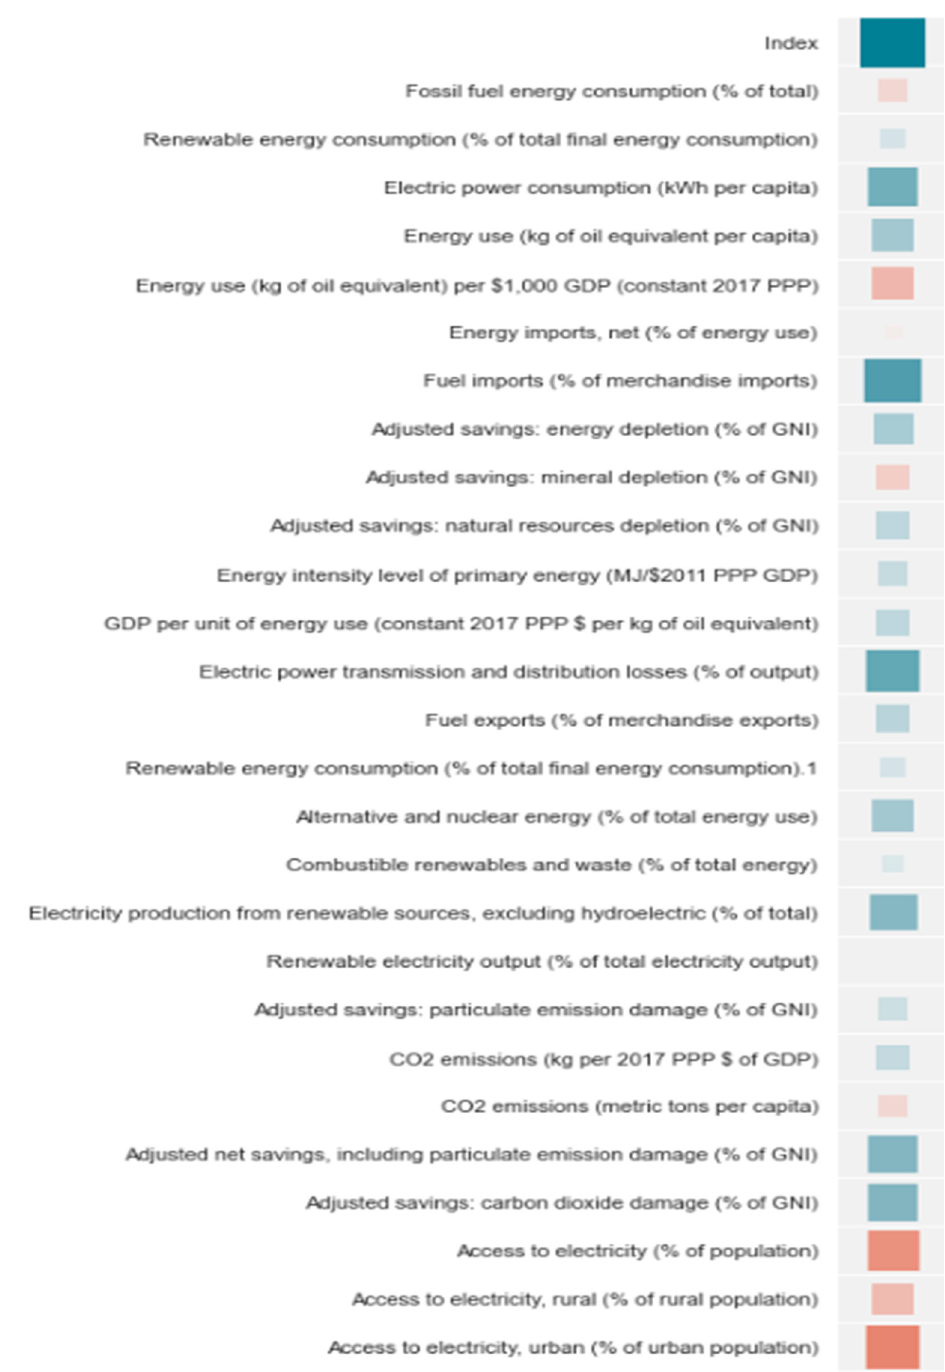
Figure 14. Correlation matrix: impact of factors on the dependent indicator.